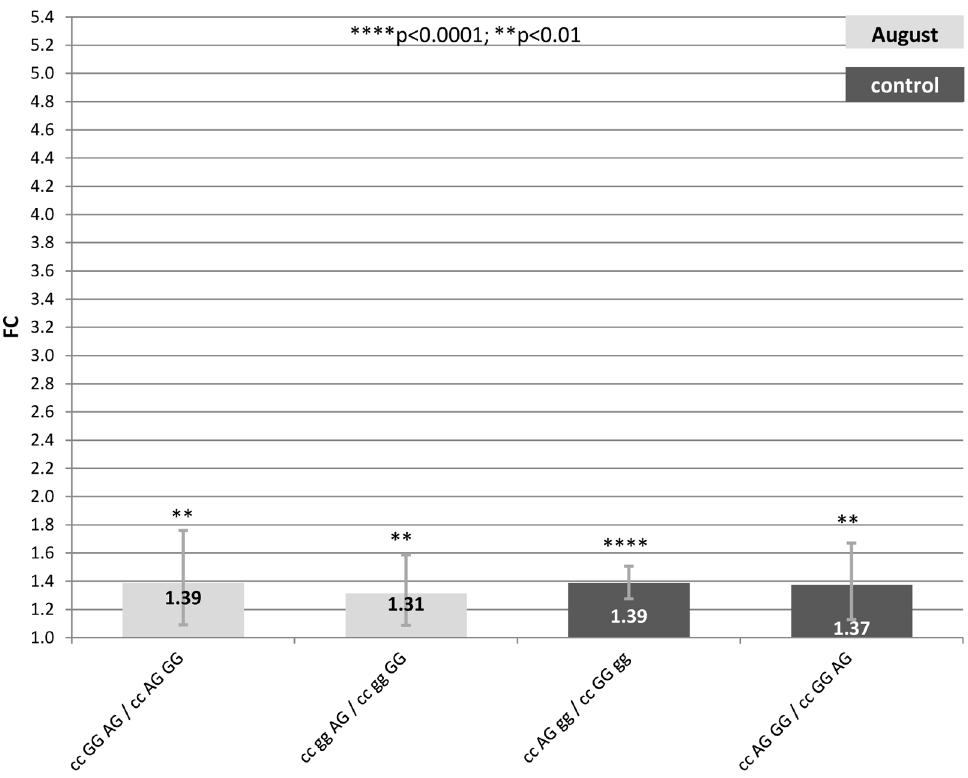
Figure 2. Fold change (FC) for the contrasts among alternative genotypes A/C 2 601 -G/A 522 -A/G 2 444 of the HSP90AA1 promoter within each treatment (Control, July and August) normalized by HSP90AB1 . Segments indicate the 95% confidence interval (FC up -FC low ).In abscissa the FC, in ordinate genotype contrasts. Asterisk over each bar indicates the significance level of the contrasts. units higher than those of July. For the control time point, temperatures and THI values indicated no heat stress conditions. Raw Cq values for all genes in each treatment are shown in Figure 4. Under control conditions, Cq values for the HSP90AA1, HSP90AB1, MDH1 and SDHA genes were 26.2, 26.6, 29.4 and 30.3, respectively. Smaller Cq values were observed for all genes in samples collected under high temperatures (July and August). They were 25.7 for both chaperones and 28.8 and 29.7 for MDH1 genes was higher in samples collected under control conditions.